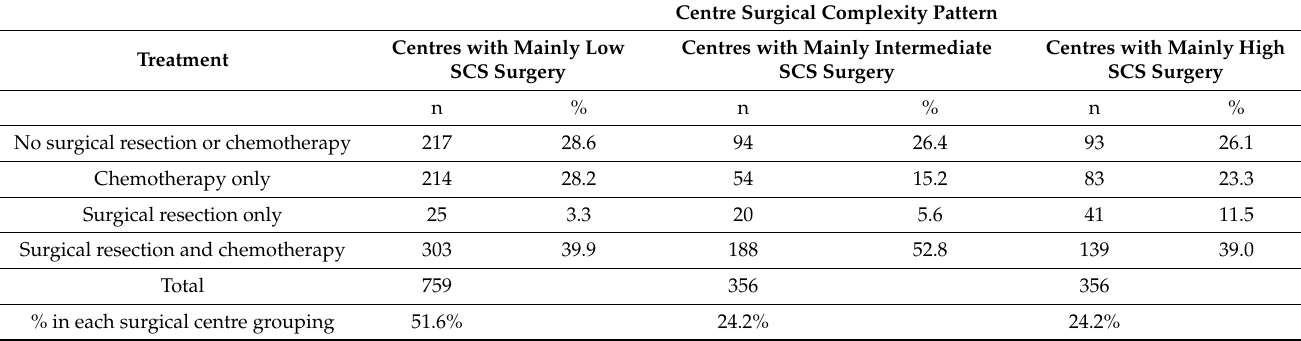
Table 2. Analysis of treatment in the whole patient cohort of 1471 women with advanced ovarian cancer by Centre surgical complexity score